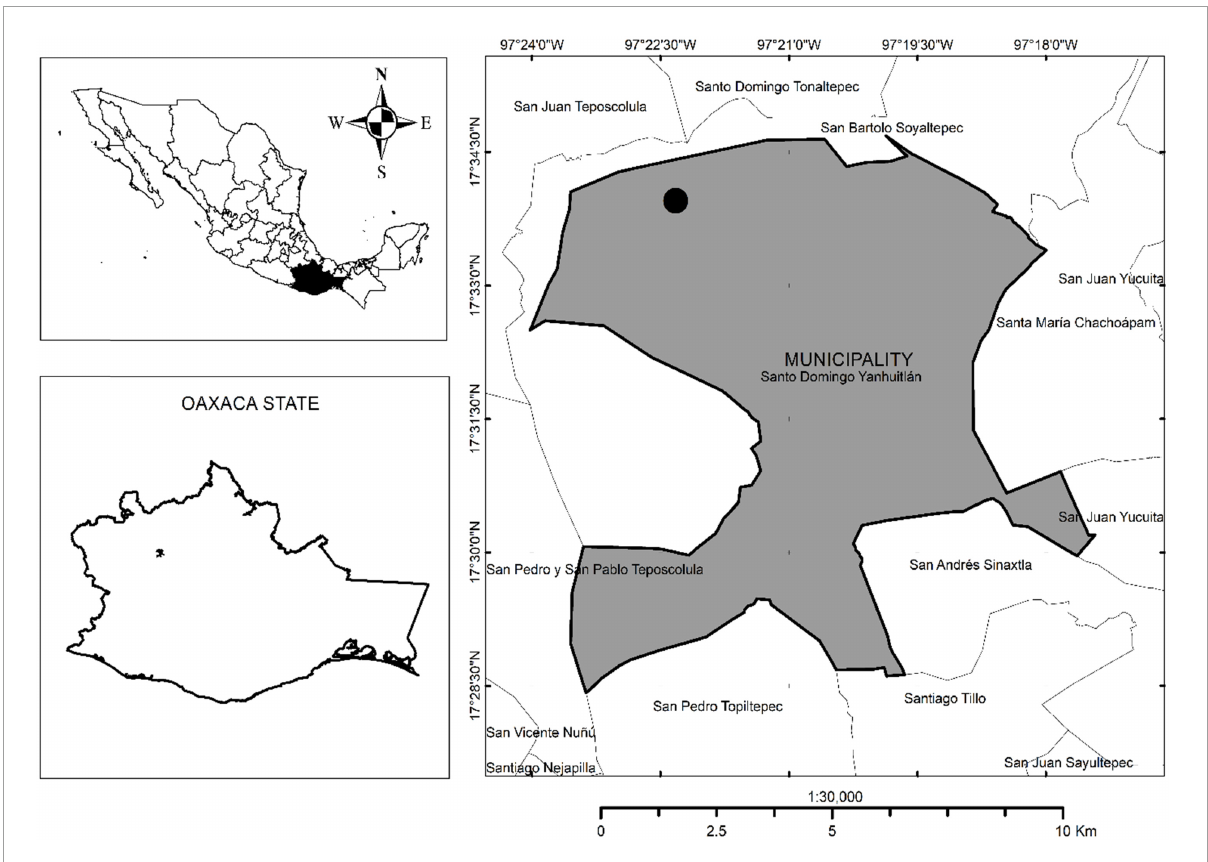
FIGURE1 Geographic location of the study area within a seasonal oak forest in the municipality of Yanhuitlán, Oaxaca,